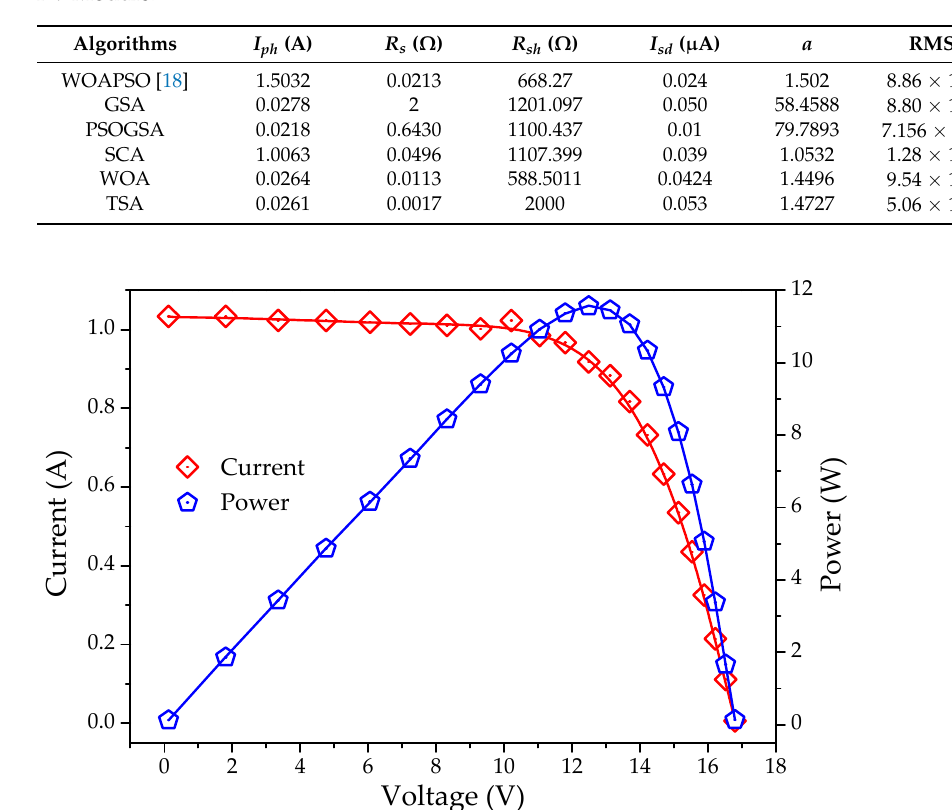
Figure 3. Current-Voltage (I-V) and Power-Voltage (P-V) characteristics curve for estimated and experimental values for single-diode model of Photowatt-PWP201 PV Module. Symbols represent measured data, and optimized data are represented by solid lines.